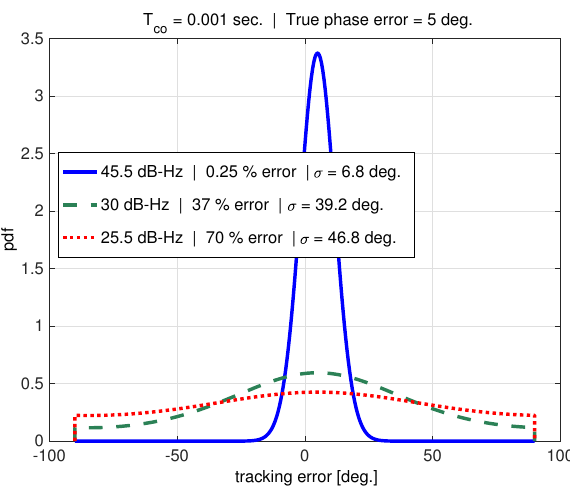
Figure 12. PDF of tracking